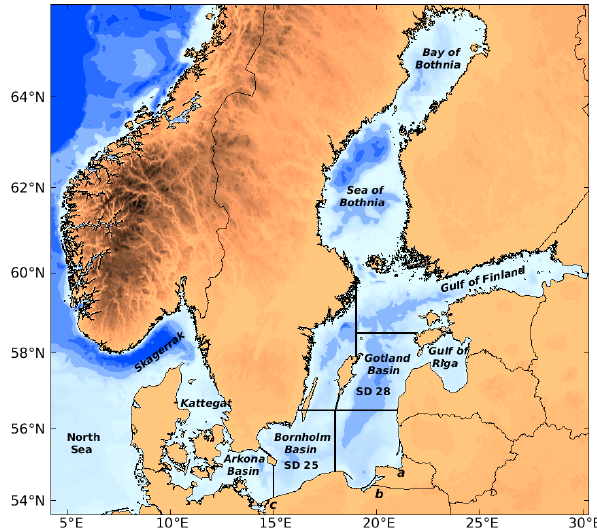
Figure 1. Map of the Baltic Sea and its sub-basins. The Baltic Proper comprises the sub-basins Arkona, Bornholm, and Gotland Basin. The Gulf of Bothnia comprises the Bothnian Sea and the Bay of Bothnia. Panels (a) – (c) denote the Curonian, Vistula, and Szczecin